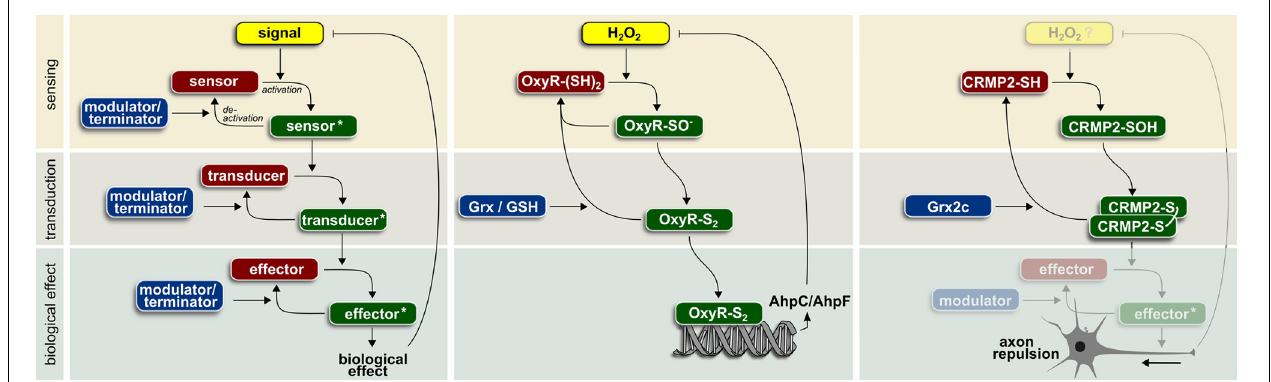
FIGURE 1 | Enzyme-based redox signaling in biological systems (for details see